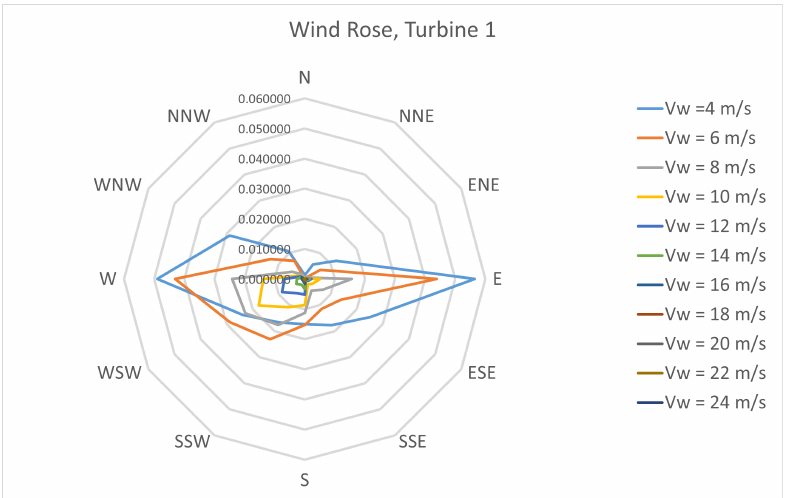
Figure A2. Wind Rose 1—wind speed and wind direction probability for wind turbine 1 with prevailing wind direction.